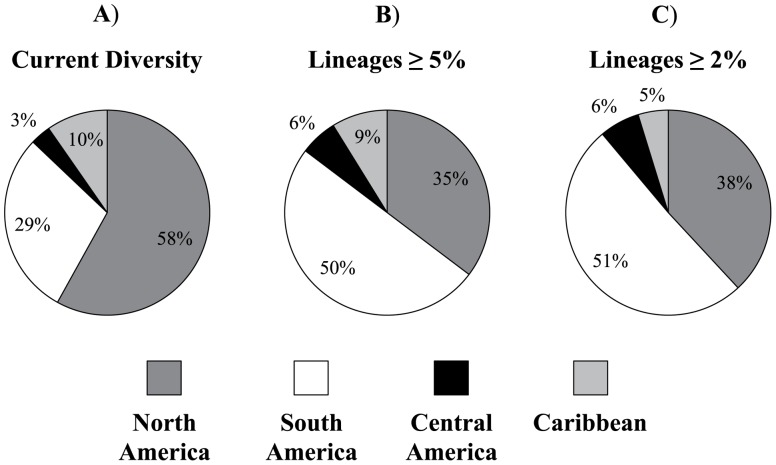
Diversity estimates based on currently recognized species and genetic lineages presented herein.The number of lineages restricted to each region (distributions based on [12]–[16]) is shown as a percentage of the total. A) percentage of diversity in each region based on currently recognized diversity, B) percentage of diversity in each region based on a species divergence level set at ≥5.0% using cytochrome-b DNA sequence data, C) percentage of diversity in each region based on a species divergence level set at ≥2.0%. Note the proportion of lineages from each region changes from the current levels, when compared to the lineages at 5.0% and 2.0%.